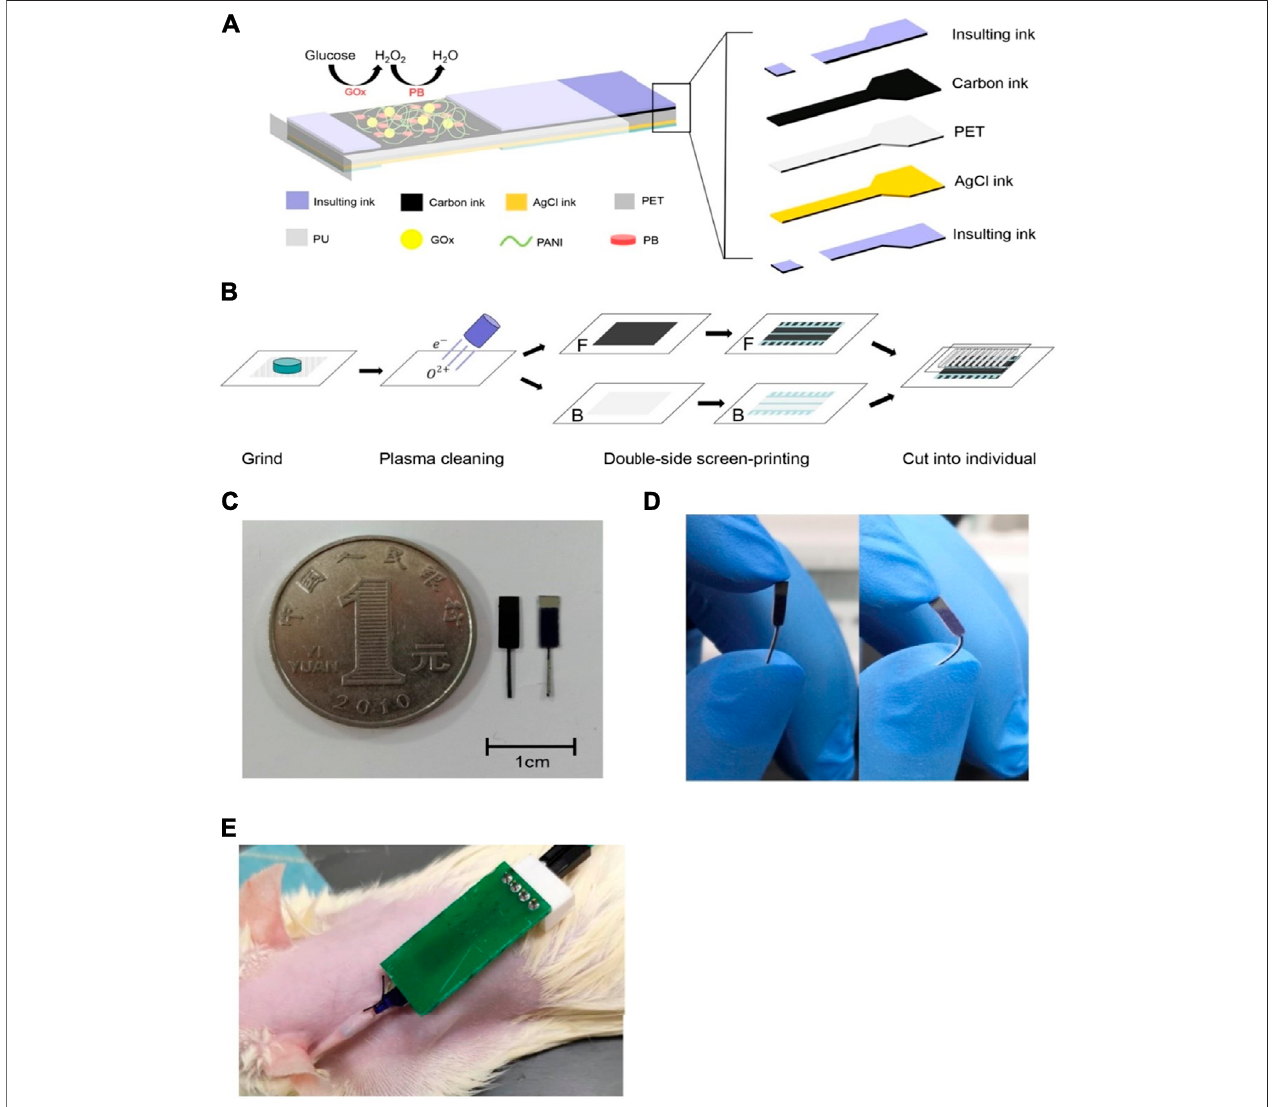
FIGURE4| Serum-basedCGMs(Caietal.,2020). (A) Thestructureoftheglucosesensor,includingpolyethyleneterephthalate(PET)substrate,workingelectrode, a counter electrode and insulating material. (B) The array of the electrodes. (C) The shape of the electrodes. (D) Photograph of the electrodes binding at 90 ° . (E) The glucose monitoring tested on a